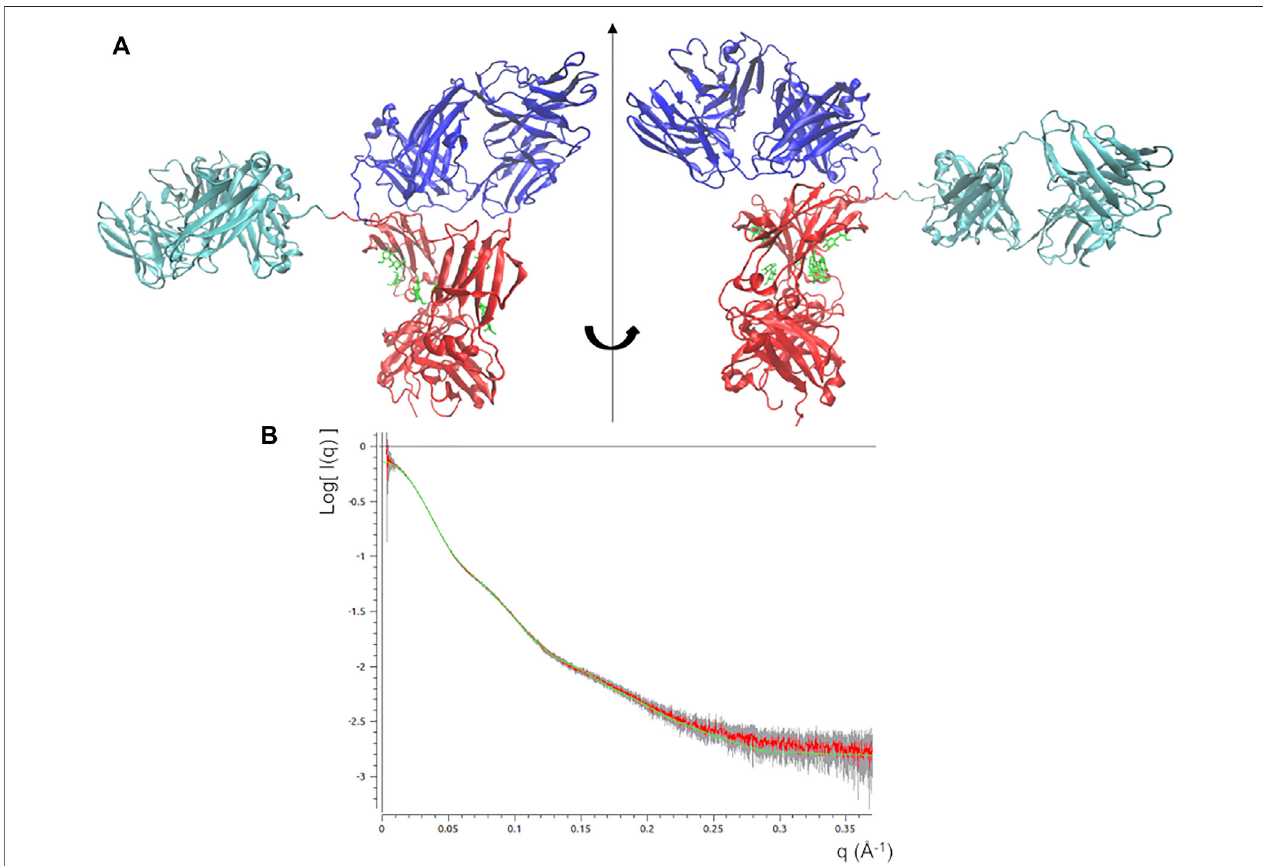
FIGURE 4 | (A) Best fi tting model obtained by the static modelling procedure based on the MDFF protocol. Fa, Fb and Fc domains are coloured in cyan, blue and red, respectively. Glycans are coloured in green and put in licorice representation. (B) Best fi t of the observed SAXS pro fi le (red line) along with experimental errors (grey bar) and that calculated scattering pro fi le from the above model (green